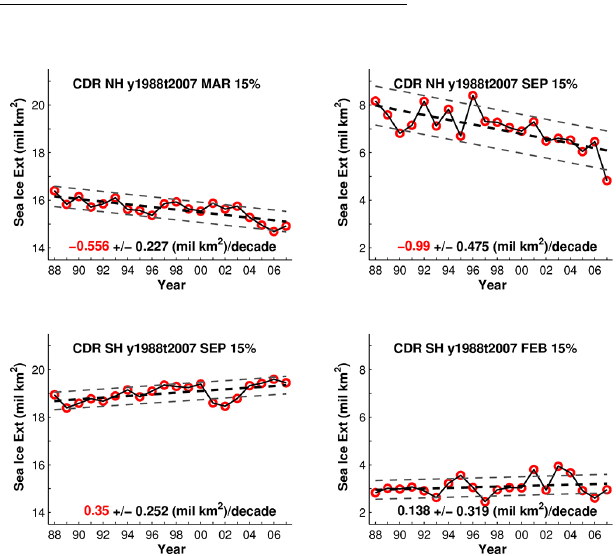
Figure 7. Same as Fig. 6 but for the annual maximum sea ice extent (left panels) and minimum (right panel) for both Northern (top pan- els) and Southern (bottom panels) Hemispheres. The decadal trend in red is significant at the 95% confidence